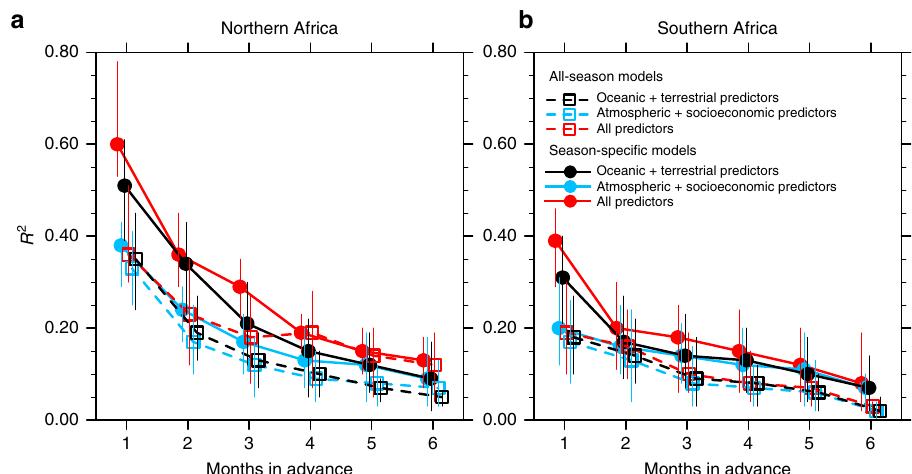
Fig. 3 Predictability of African fi re by leading time. The predictability of African fi re carbon emission anomalies is estimated using multiple machine learning techniques (MLTs) as a function of lead time. The predictability is represented by the squared correlation coef fi cient ( R 2 ) between the predicted and observed monthly anomalies ( n = 60) of the regional average fi re carbon emissions across the a northern and b southern African ecoregions. The assessed sets of predictors include previously identi fi ed atmospheric and socioeconomic predictors (blue), currently identi fi ed oceanic and terrestrial predictors (black), and the combination of all these predictors (red). The assessed models include season-speci fi c models ( fi lled circles), in which the MLTs are built and applied by season, and all-season models (open squares). The circles and squares indicate the mean R 2 across the 100 ensemble members of the best MLT (see the Methods section), and the vertical lines indicate the range of 10th and 90th percentiles of the 100 ensemble members.